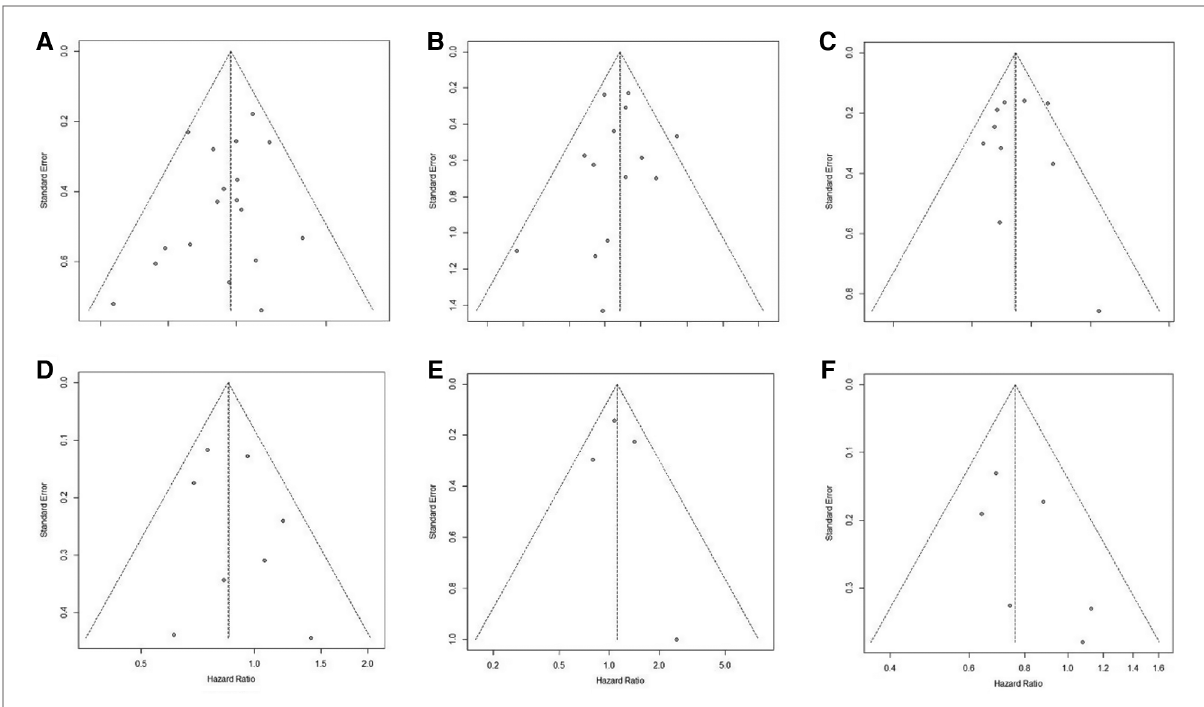
FIGURE 4 Funnel plot of publication bias in the meta-analysis. ( A ): pCR; ( B ): R0 resection; ( C ): OS; ( D ): DFS; ( E ): LRFS; ( F ):